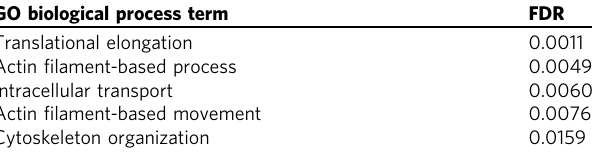
Table 2 Functional gene-set analysis (GO) of co-precipitated